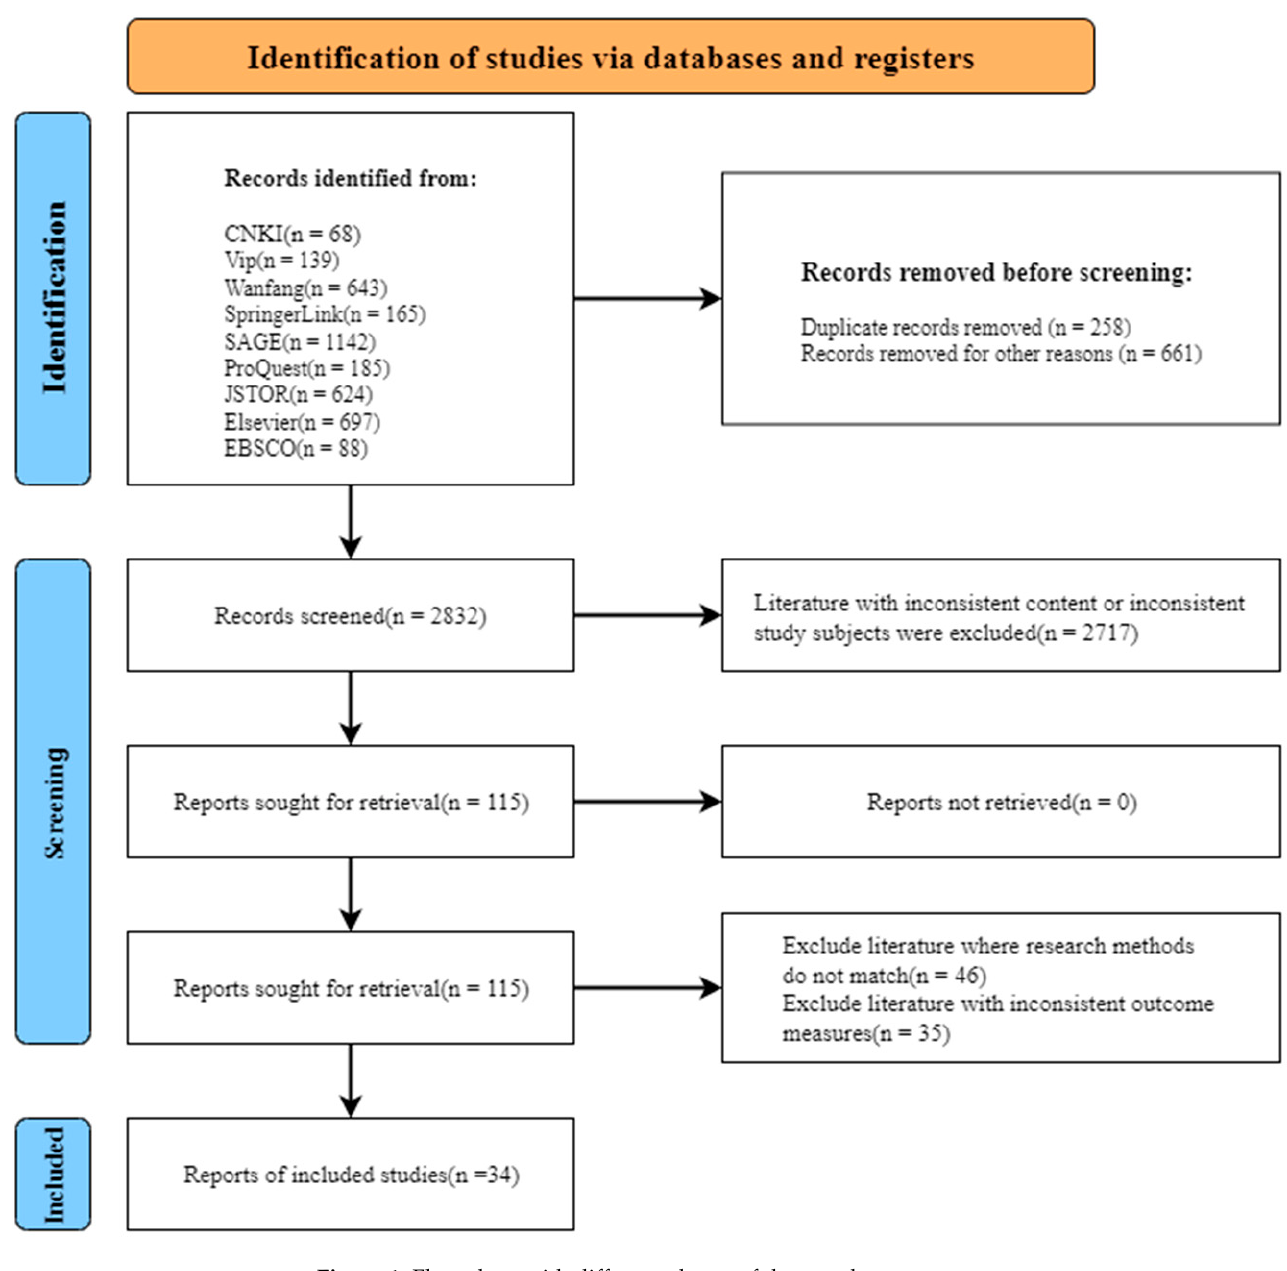
Figure 1. Flow chart with different phases of the search process.